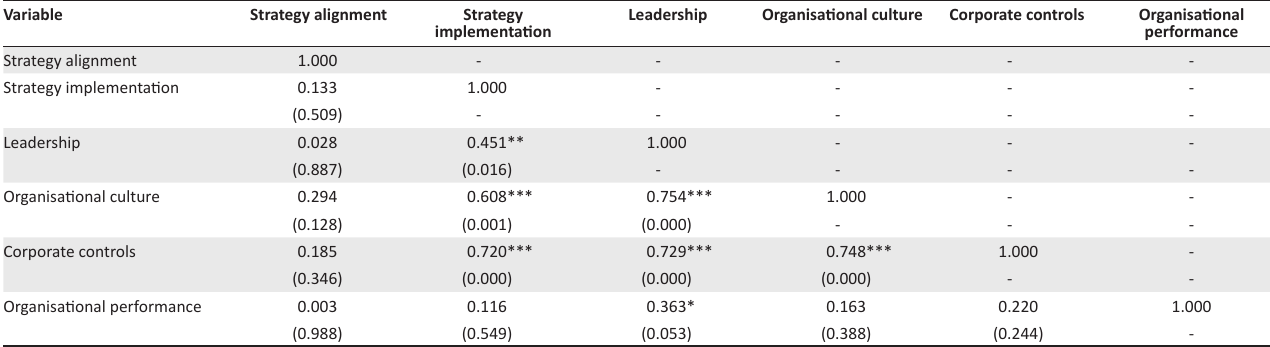
TABLE 4: Correlational matrix.